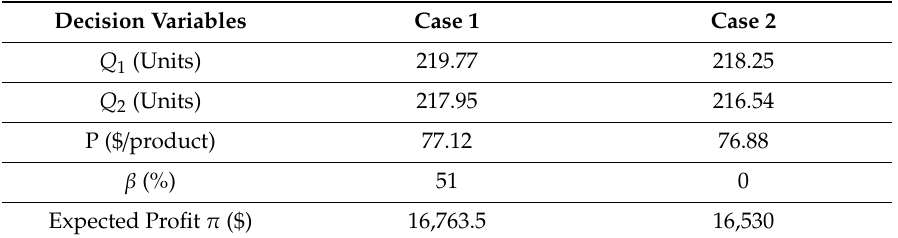
Table 1. Optimal results of Case 1 and Case